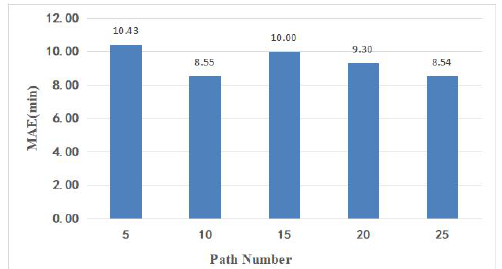
Figure 17. MAE with a varying quantity of paths